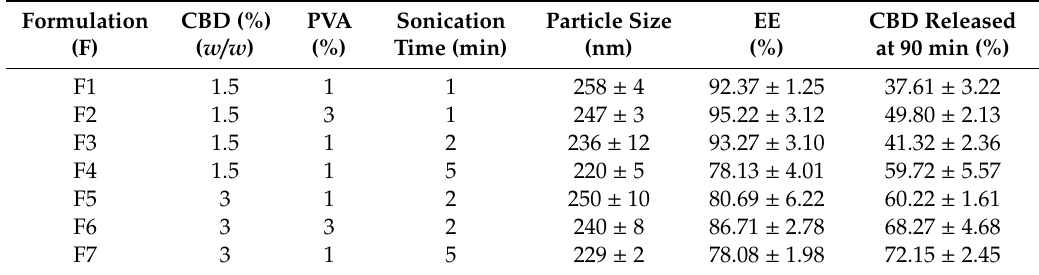
Table 1. Characteristics of the formulations elaborated by the evaporation-extraction method during the optimisation process ( n = 4). CBD: cannabidiol, PVA: polyvinyl alcohol and EE: encapsulation e ffi ciency.